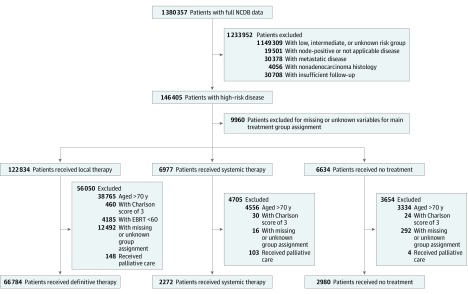
Flow Diagram of Patient Eligibility and InclusionEBRT indicates external beam radiation therapy; NCDB, National Cancer Database.